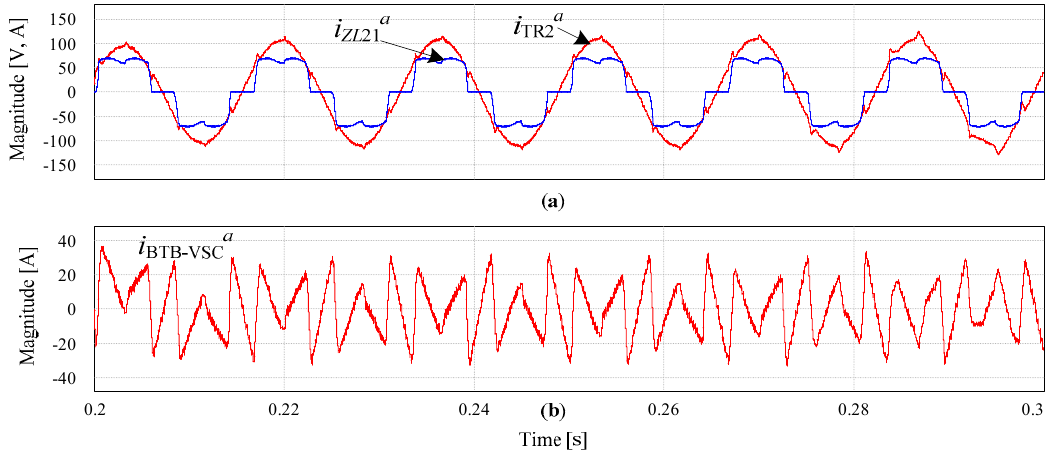
Figure 12. BTB-VSC performances when it compensates active and reactive power and the current harmonics: ( a ) current waveforms for the load, i ZL 21 a (blue) and for TR2, i TR2 a (red) after compensation (red). ( b ) Current waveform generated by BTB-VSC.